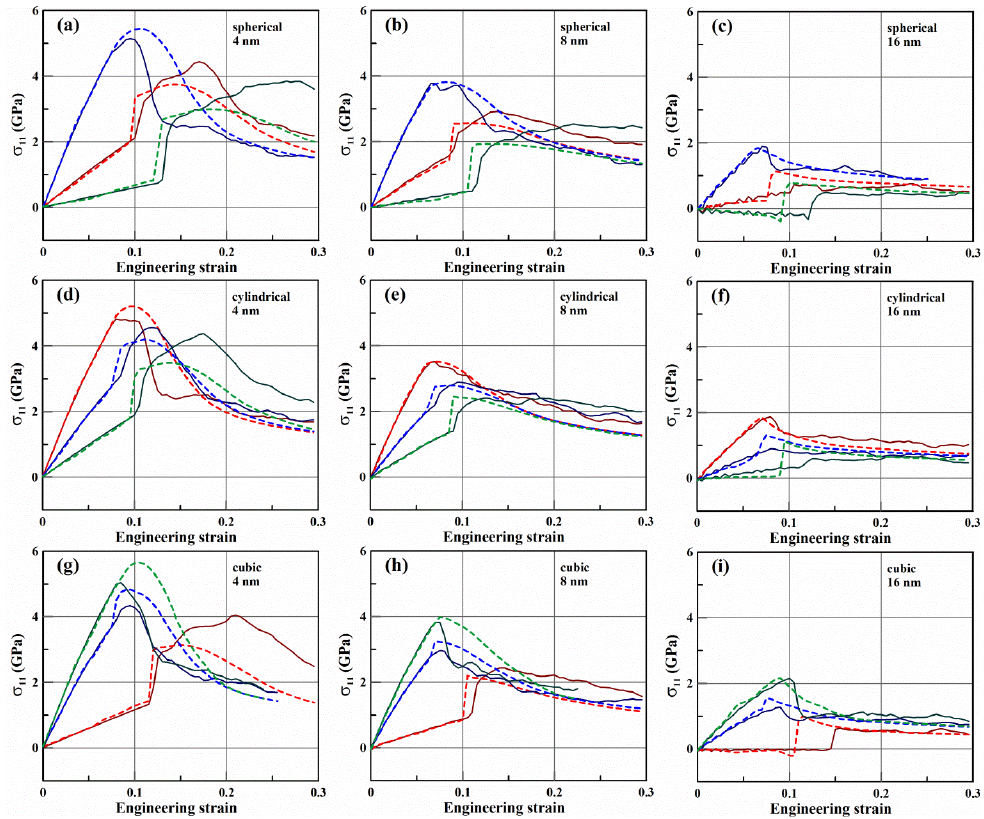
Figure 11. Comparison of the MD (solid lines) and the plasticity and fracture model (dashed lines) for evolution of longitudinal stress σ 11 in nanoporous aluminum with: ( a – c ) spherical pores, ( d – f ) cylindrical pores, and ( g – i ) cubic pores. The equivalent pore size d is equal to ( a , d , g ) 4 nm, ( b , e , h ) 8 nm, and ( c , f , i ) 16 nm; the temperature is 300 K. Different colors of solid and dashed lines (red, blue and green) in each plot show different random deformation paths, which are paths #3, 9, and 18 for spherical pores ( a – c ), paths #11,14, and 15 for cylindrical pores ( d – f ), and paths #4, 10, and 17 for cubic pores ( g – i ),